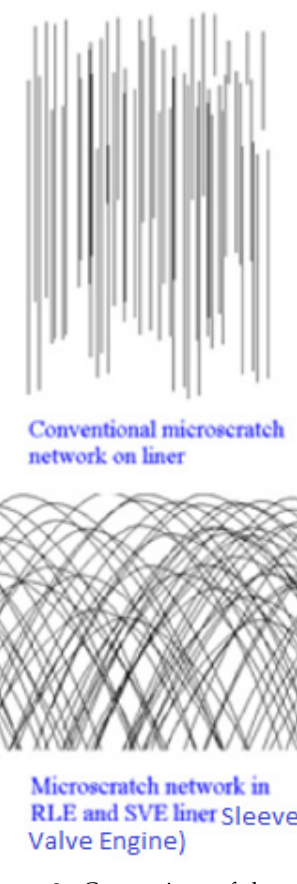
Figure 1. Instantaneous frictional torque of a single cylinder Diesel [2]. This particular case exam- ined the effect of lubricant viscosity in instantaneous friction. The unclear legends in the figure refer to the oil temperature (57 °C) and the load.